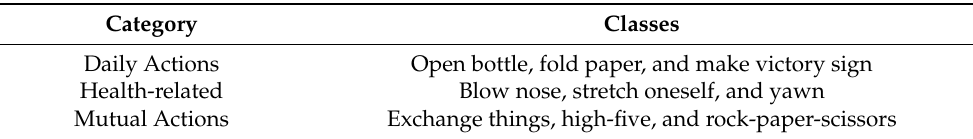
Figure 5. Samples from NTU-RGB+D dataset. Top: A17—take off a shoe; Bottom: A48—nausea/ vomiting. Table 2. Examples of activities from NTU-RGB+D 120